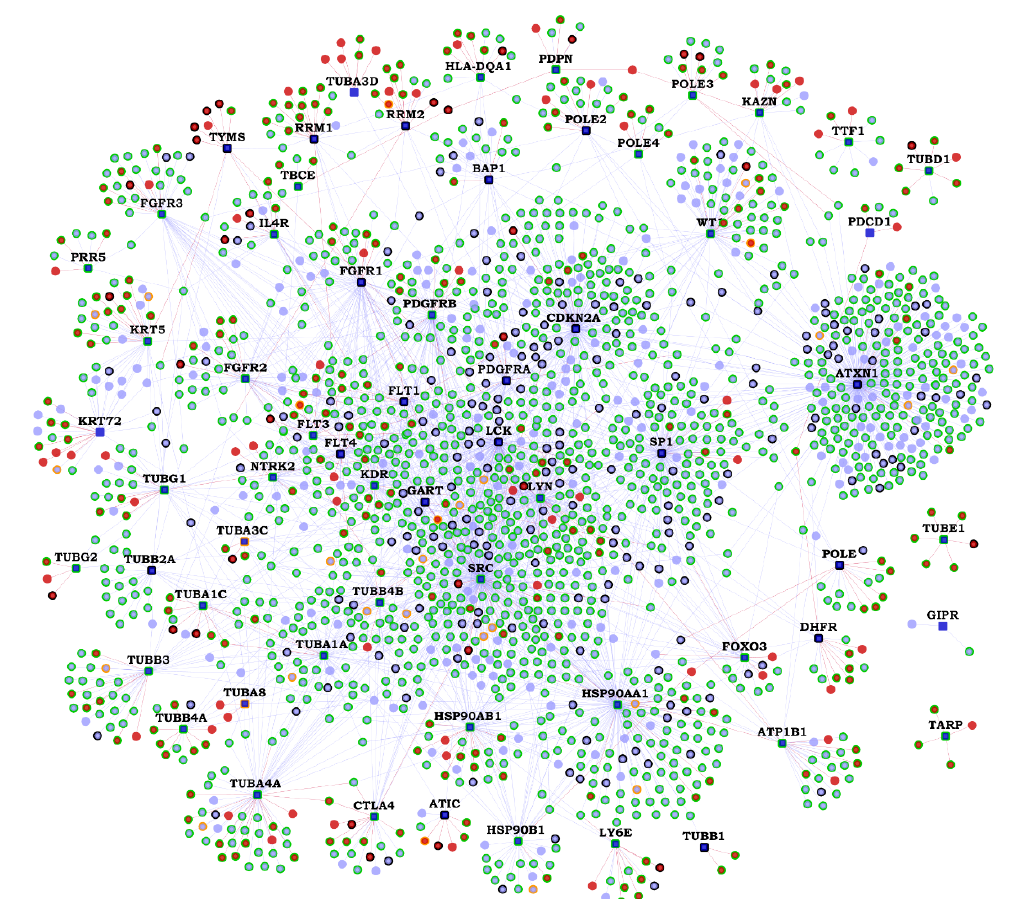
Figure 6. Genes with biological evidences in the malignant pleural mesothelioma (MPM) Protein-Protein Interactome: On the interactome network shown in Figure 1, various biological evidences of relation to malignant pleural mesothelioma (MPM) are shown as node border colors. Genes with variants associated with MPM have orange borders, genes with MPM/lung cancer/asbestos exposure-associated gene/protein expression changes have light green-colored borders and genes with black border have both genetic variants and gene/protein expression changes associated with them. The gene expression-associated features include differential expression in MPM tumors versus normal adjacent pleura, MPM tumors versus other thoracic tumors, differential gene methylation (affecting gene expression) in MPM tumors, gene expression correlated with unfavorable lung cancer prognosis, differential gene expression on exposure to asbestos or asbestos-like particles and high/medium expression in normal lungs. The protein expression-associated features include isolation as exosome-derived proteins from malignant mesothelioma cell lines and differential protein abundance levels in epithelioid and sarcomatoid types of malignant mesothelioma. The complete list of genes in the interactome and their corresponding evidence can be found in Data File S5.